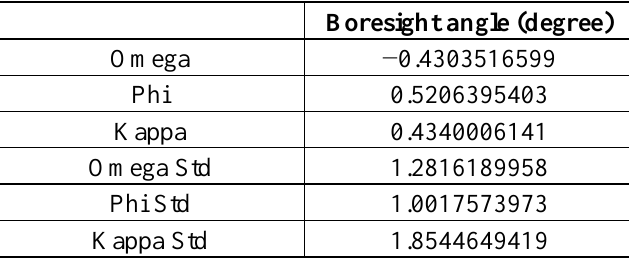
Table 5. Result of boresight angle